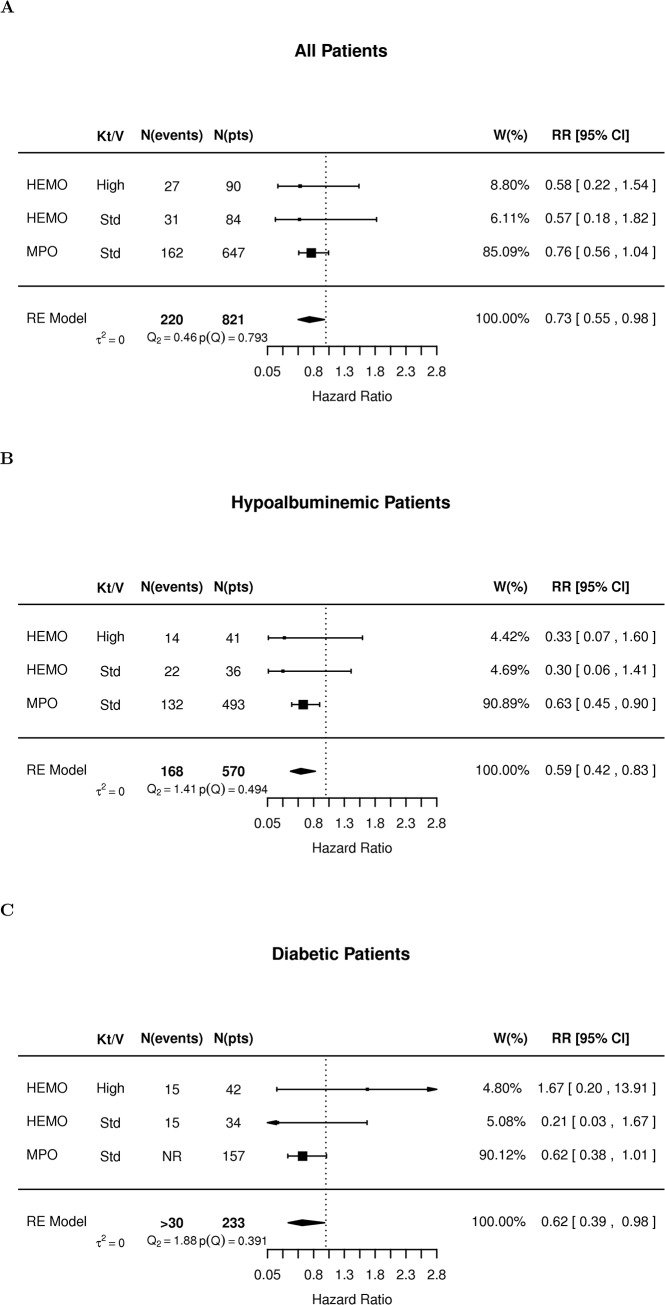
Meta-analysis of adjusted Hazard Ratio in HEMO study participants dialyzed with non-reused HF membranes and MPO patients.(A) all patients, (B) hypo-albuminemic patients, (C) patients with diabetes.